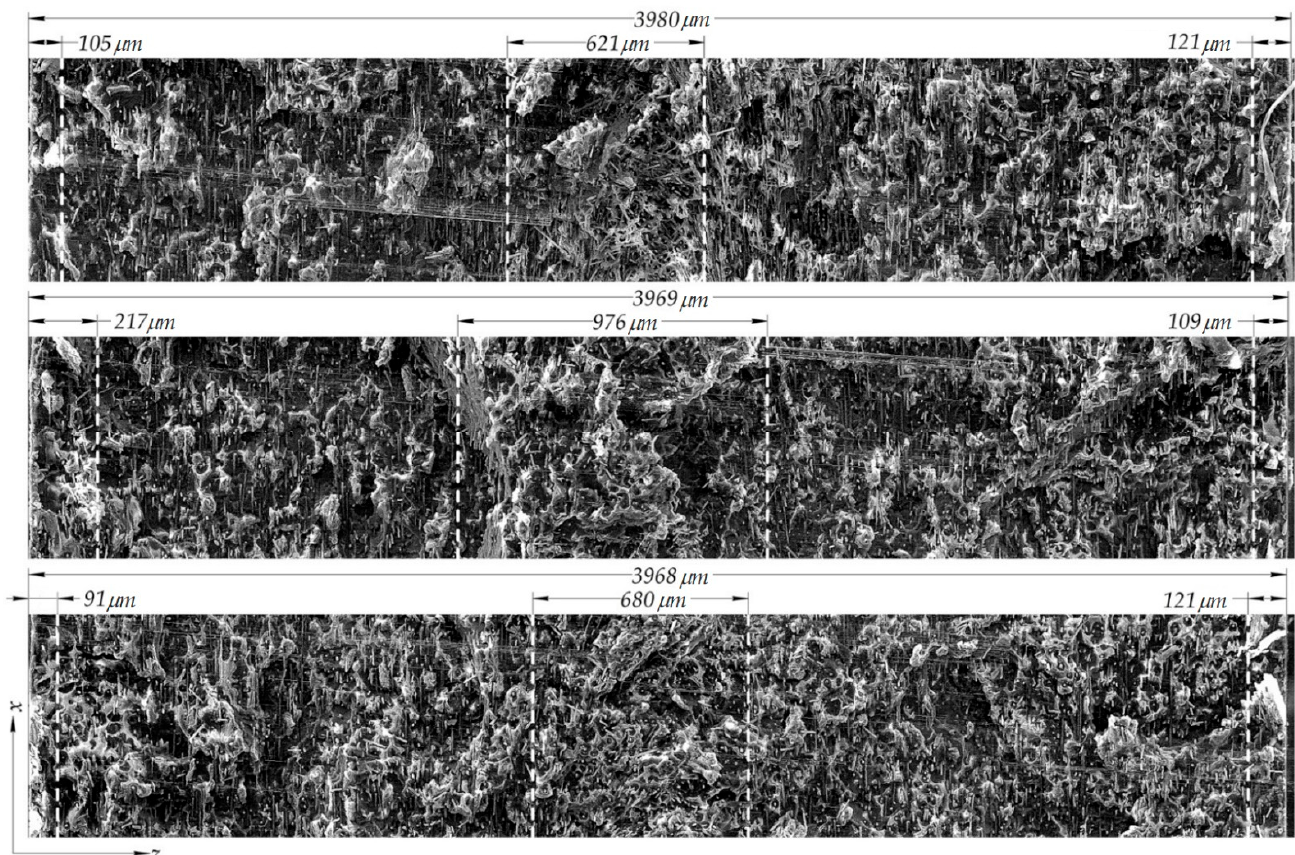
Figure 7. Fracture surface of short-fiber reinforced PA6 with 15% carbon-fiber mass fraction, ISO 527-2 sample, orientated at 90 ° . Dashed lines demark the size in micrometers of the skin and core layer.